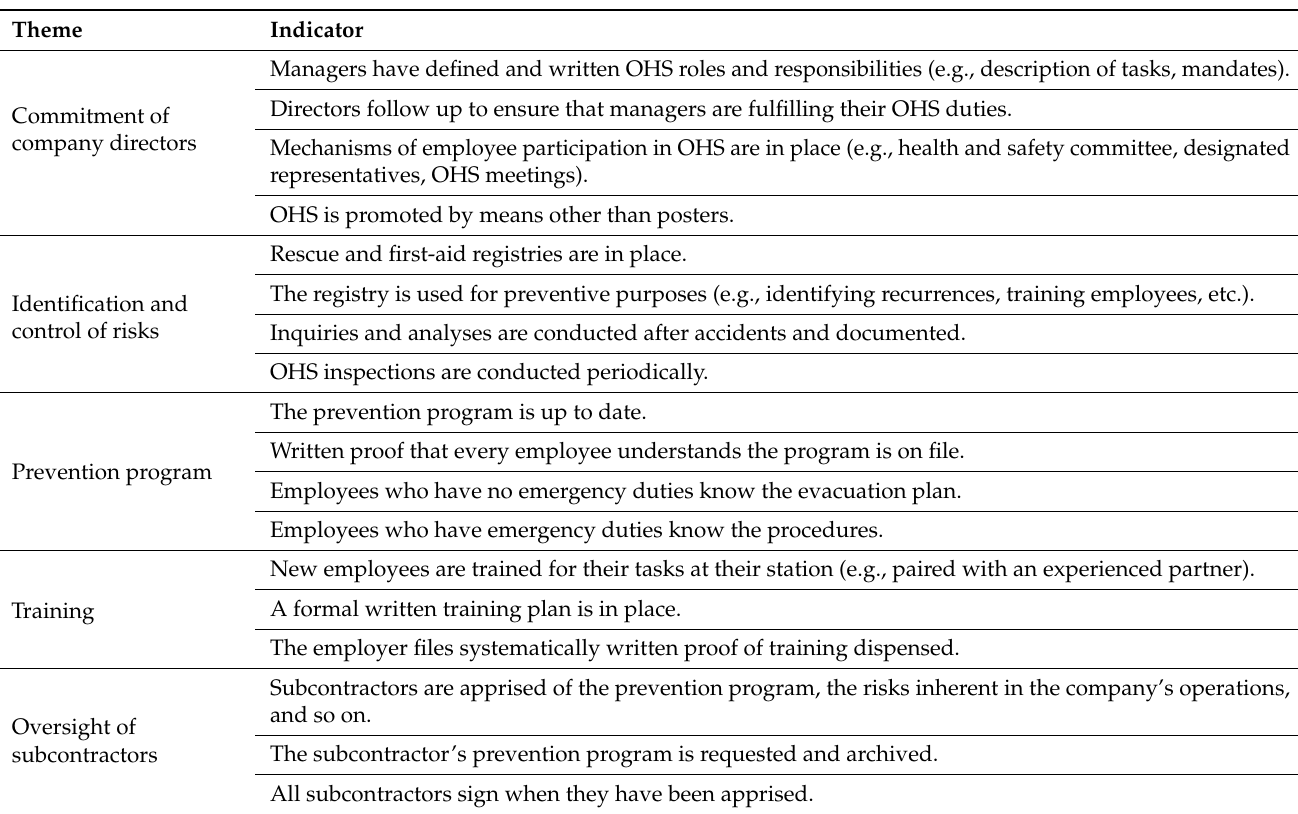
Table 13. Indicators of the “organizational” dimension